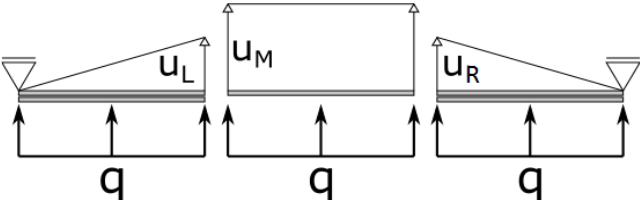
Fig. 8 Qualitative deformation Fig.s of the balustrade’s three elements in top